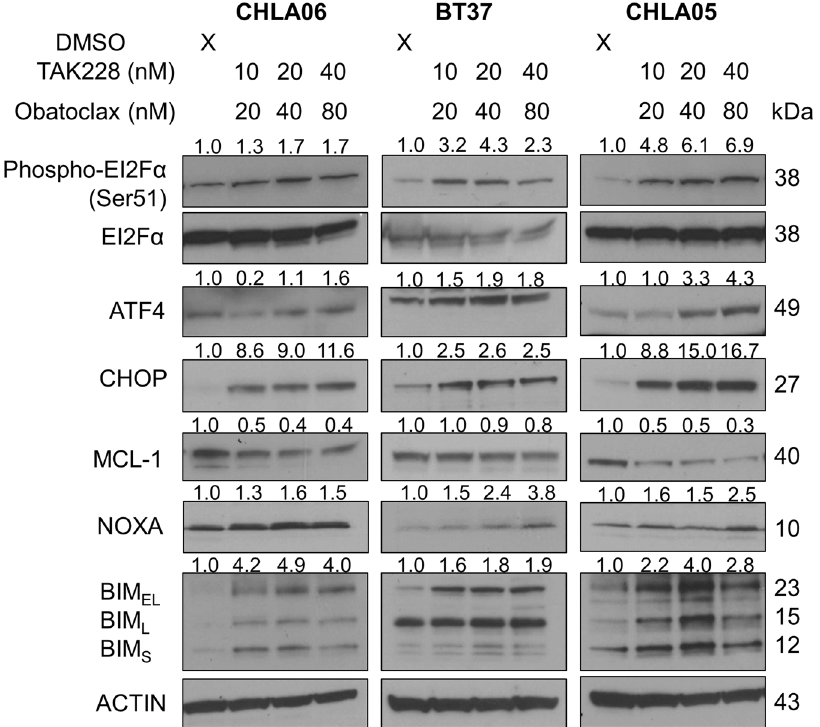
Fig. 6 Combination therapy activates the integrative stress response and disrupts the NOXA.MCL-1.BIM axis, making stressed cells more prone to selection for apoptosis. Western blots in CHLA06, BT37, and CHLA05 cell models of AT/RT 24 h after DMSO control treatment and increasing fi xed dose ratios of combination TAK-228 and Obatoclax treatment. Numbers above phospho-EI2F α (Ser51) represent quanti fi cation of expression normalized to EI2F α . Numbers above other blots represent quanti fi cation of protein expression normalized to medication alone (Fig. 8A) with a median survival increasing from doses administered weekly). Mice tolerated the treatment with no 34 to 55 days. About 25% of mice had a durable response to signi fi cant change in weight compared with vehicle controls combination therapy. Bioluminescent imaging (BLI) demonstrated (Supplementary Fig. 6A). Combination treatment signi fi cantly slower growth and a complete response in a subgroup of mice improved survival compared with vehicle control and each